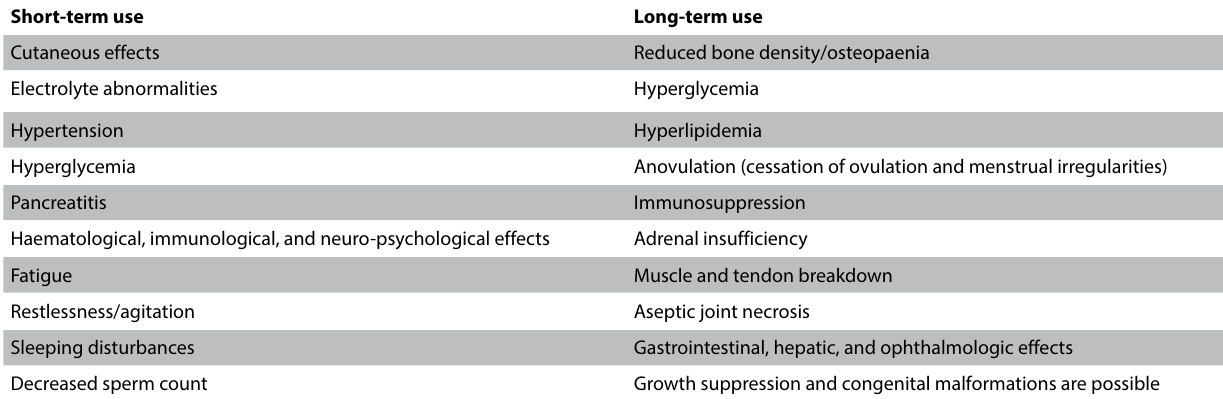
Table l: Systemic side effects of short-term and long-term corticosteroid use Short-term